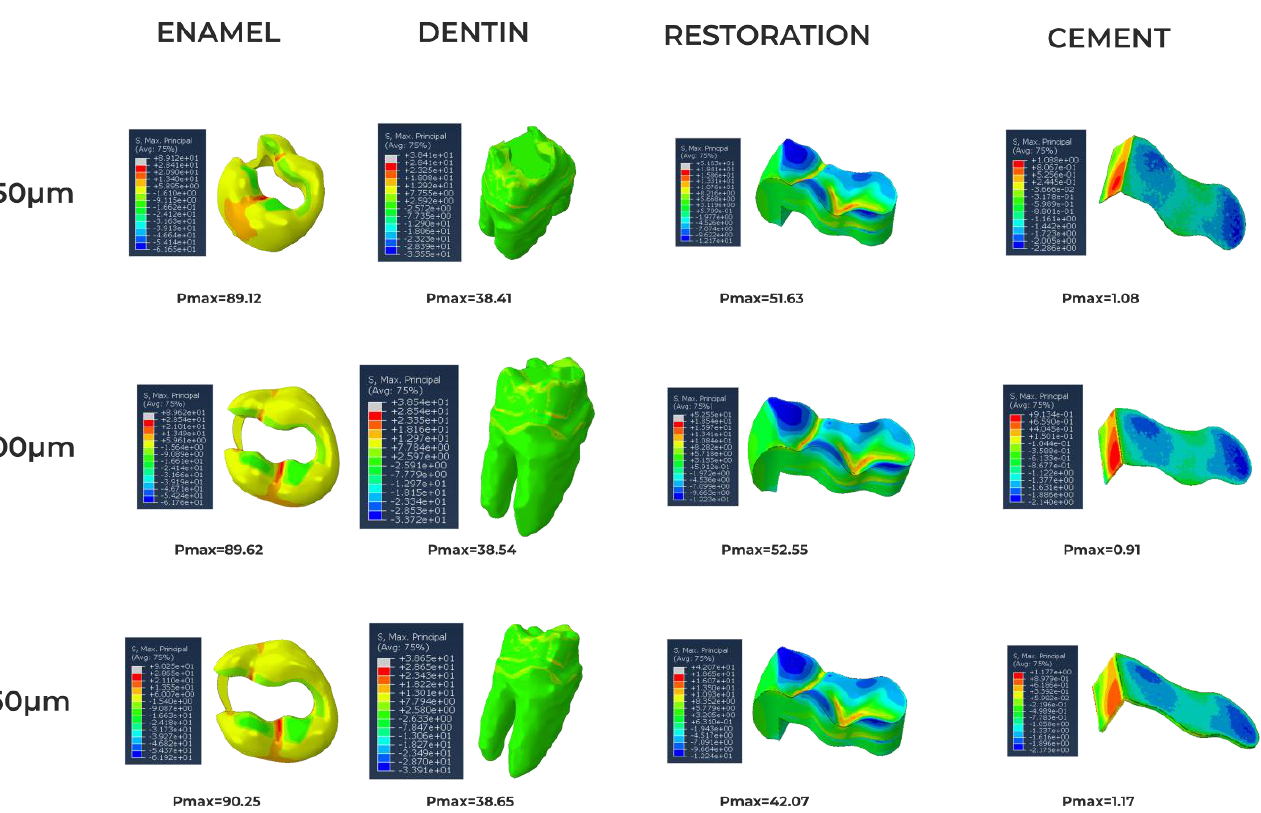
Figure 3. Maximum principal stress distribution in the enamel, dentin and restoration, compared with different thicknesses of RC used with the amalgam (35 GPa Young’s modulus of amalgam). It was observed that dentin tissue was not different to enamel tissue in terms of cement thickness and stress decreasing. 38.65 MPa stress accumulation was observed in the presence of 150 μ m thick cement, 38.54 MPa in 100 μ m thick cement and 38.41 MPa in 50 μ m thick cement (Figure 4).